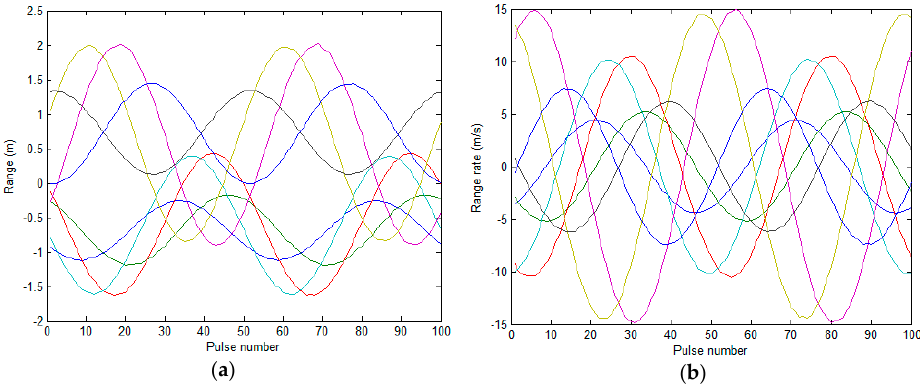
Figure 6. 1D range and range rate data association result: ( a ) 1D range data association result; ( b ) range rate data association result. Sensors 2017 , 17 , 366